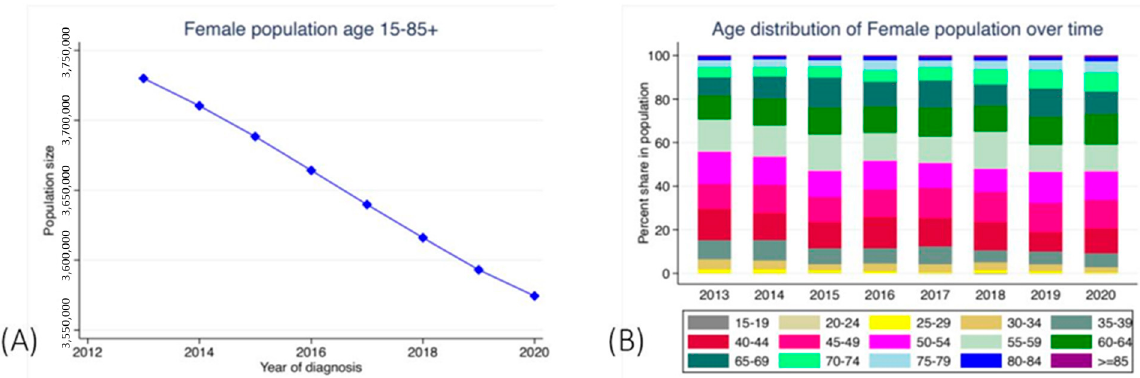
Figure 2. Distribution of women population with CUC according to ( A ) year and ( B ) age group.